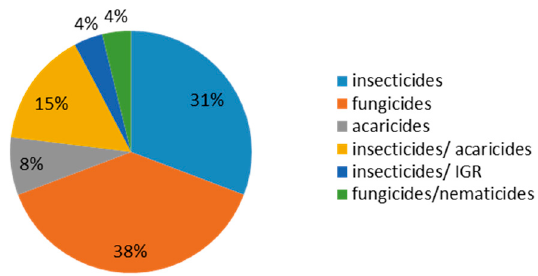
Figure 1. Illustration of the most important chemical groups and their percentages.